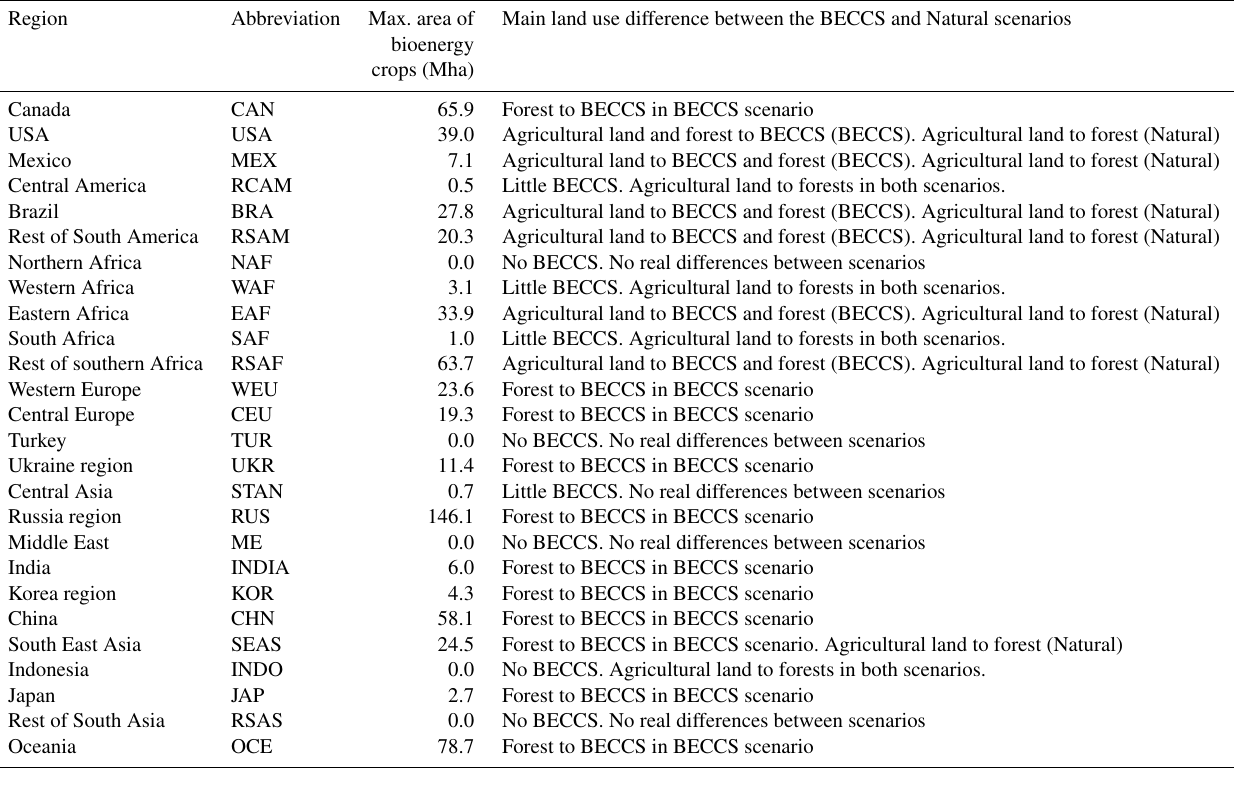
Table 2. IMAGE regions, the maximum area of BECCS deployed (Mha), and the main differences in land use between the BECCS and Natural